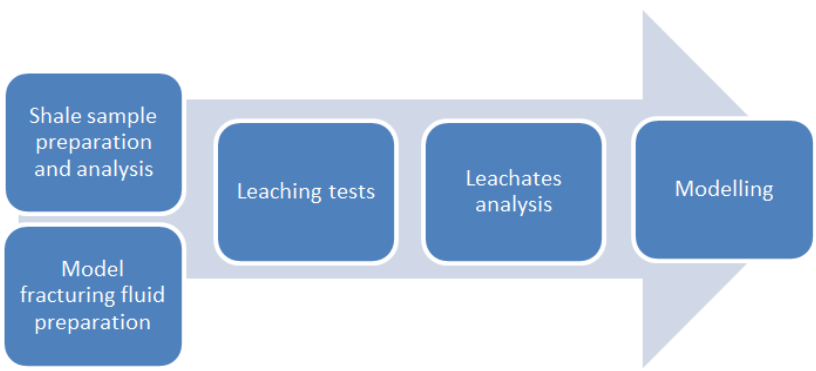
Figure 2. Overall conceptualization of data generation and processing.